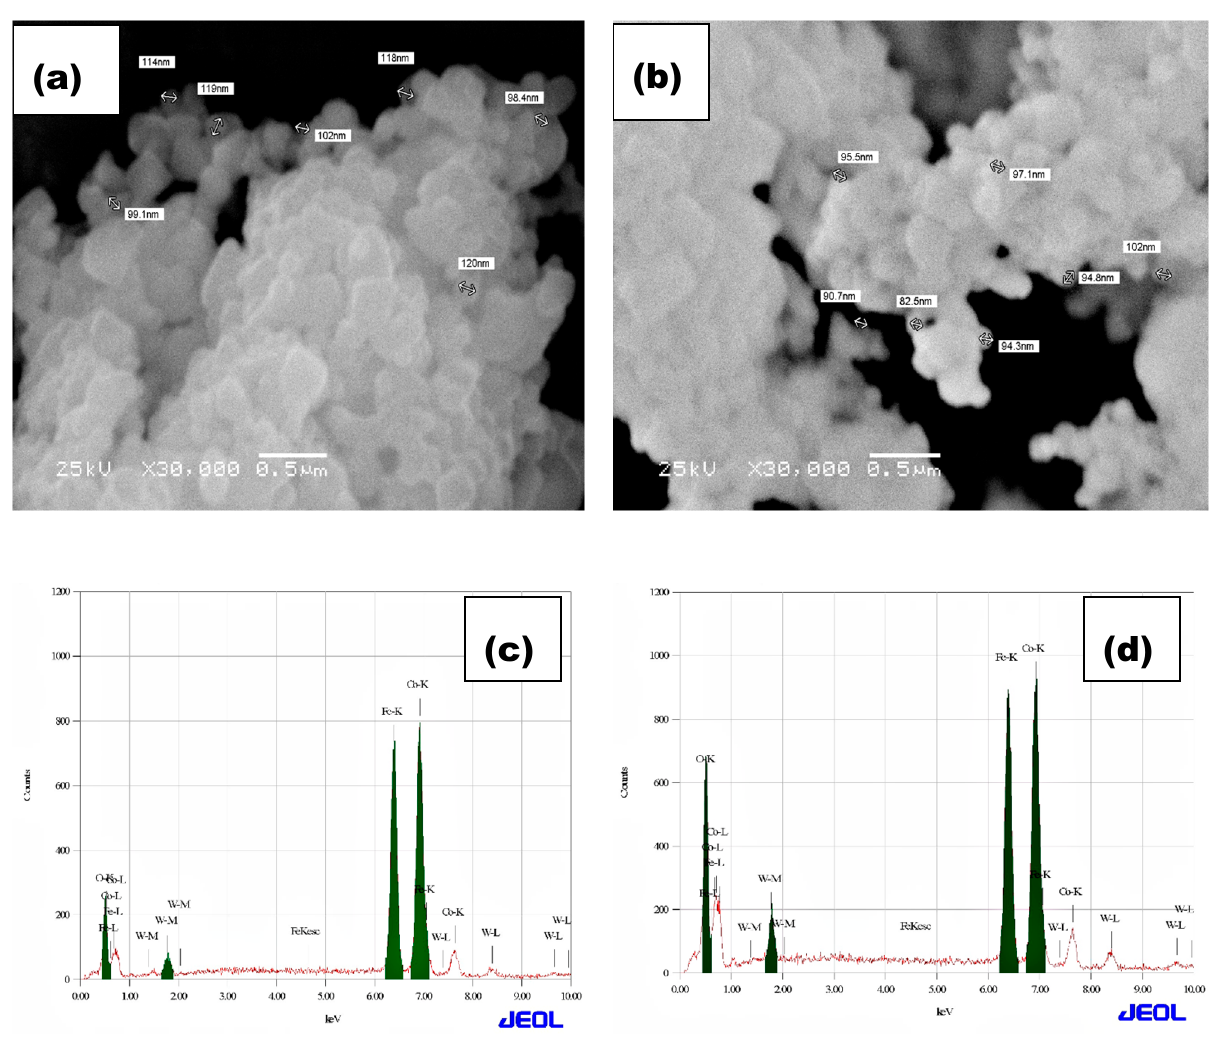
Figure 5. SEM of ( a ) CoFe 2 O 4 (0.1% W-doping), and ( b ) CoFe 2 O 4 (0.15% W-doping), and EDX of ( c ) CoFe 2 O 4 (0.1% W-doping), and ( d ) CoFe 2 O 4 (0.15% W-doping).